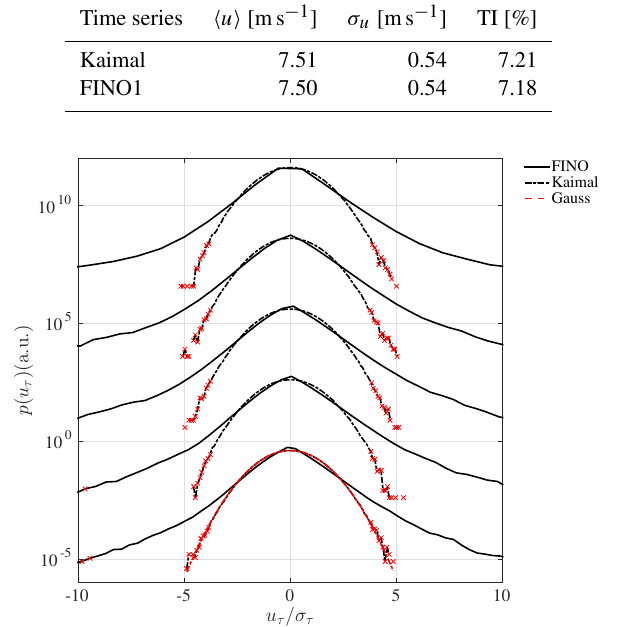
Figure 1. p ( u τ ) for data sets based on the Kaimal model (dashed black line) and for offshore measurements, conditioned so that (cid:104) u (cid:105) = 7 . 5 ± 0 . 5ms − 1 (solid black). The PDFs for each scale are shifted vertically for better comparison, which is done throughout this paper. Scales from top to bottom τ = { 1 , 5 , 10 , 30 , 60 s }